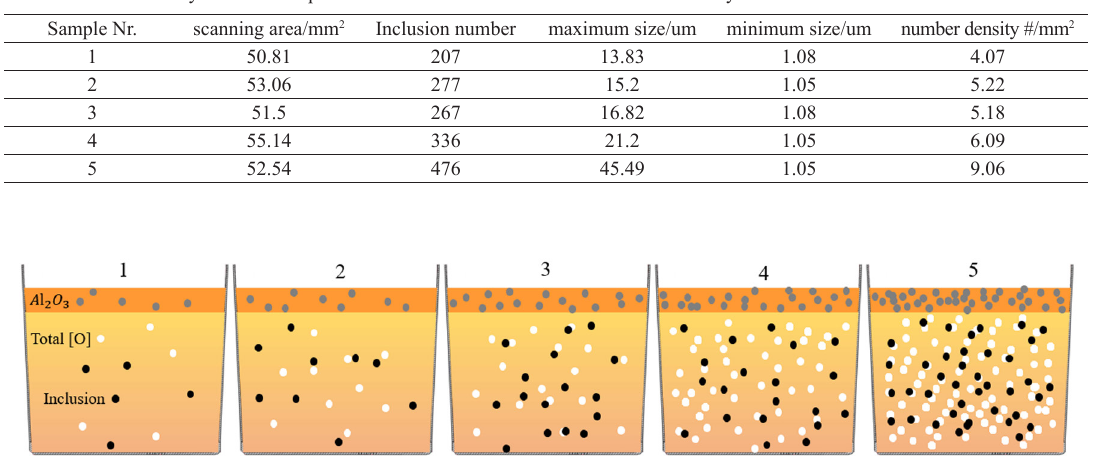
O content in refining slag, the T.O content and number density of inclusions in molten steel of 2 3